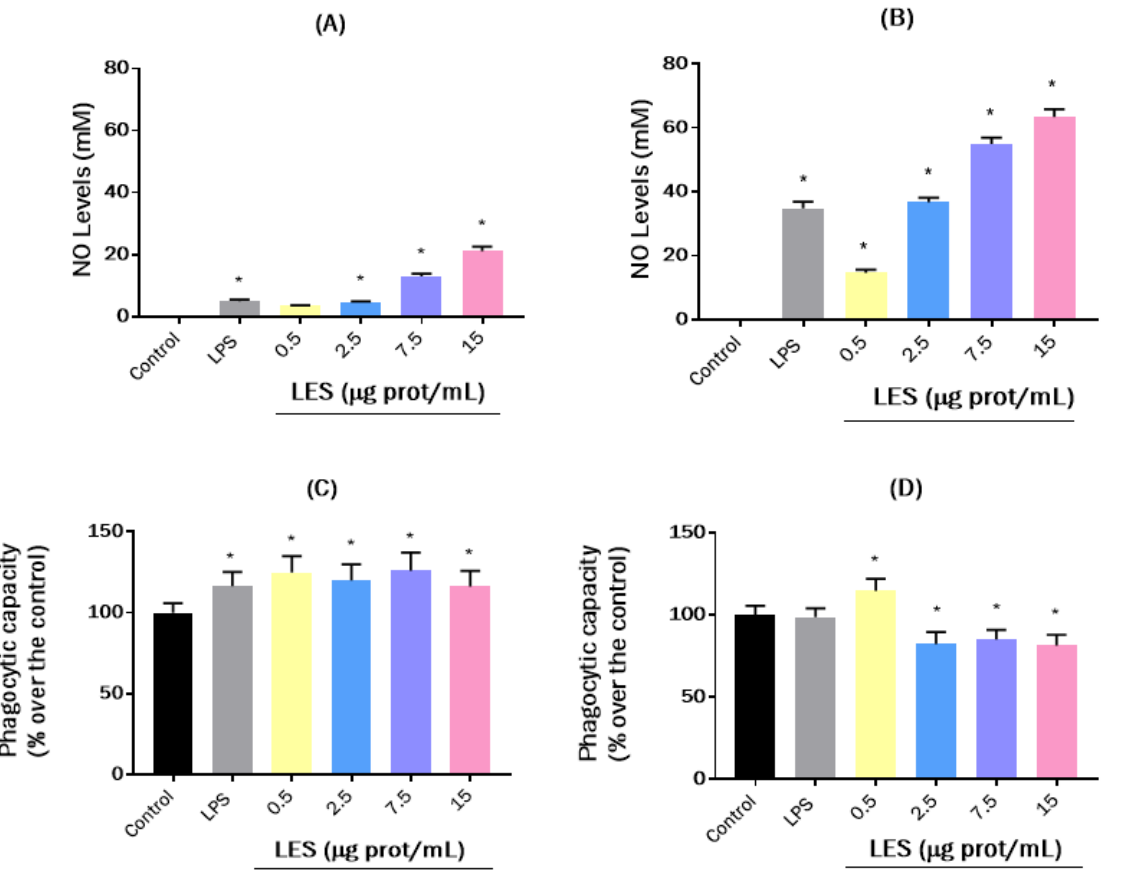
Figure 3. Immunomodulatory effects of lunasin-enriched soybean extract (LES) on RAW264.7 macrophages. ( A , B ) Effects of lunasin-enriched extract (LES, 0.5–15 µ g protein/mL) on nitric oxide (NO) levels in RAW264.7 cells after ( A ) 8 h and ( B ) 24 h of treatment. ( C , D ) Effects of LES (0.5–15 µ g protein/mL) on the phagocytic capacity of RAW264.7 cells after ( C ) 8 h and ( D ) 24 h of treatment. LPS was used as a positive control at a concentration of ( A , B ) 100 ng/mL for NO induction and ( C , D ) 10 ng/mL for phagocytic capacity stimulation. Significant differences compared to control: * p < 0.0001.